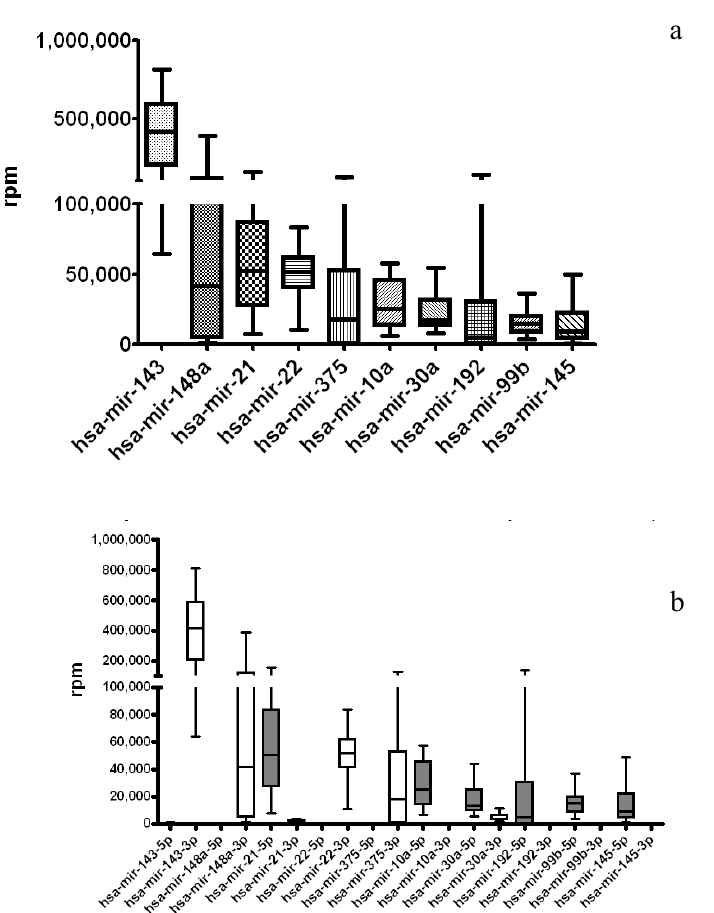
Figure 3. Distribution of the top ten expressed miRNAs from the TCGA (the Cancer Genome Atlas) normal gastric tissue dataset. miRNA expression data of 38 normal samples in TCGA stomach adenocarcinoma (STAD) libraries were re-analyzed using the new arm feature list. ( a ) The rpm (reads per million) values of each miRNAs were tabulated by combining the 5p-arm and 3p-arm together to represent the miRNA loci expression; ( b ) 5p-arm and 3p-arm expression levels were tabulated separately and displayed. miR-143 is the most expressed miRNA in the TCGA clinical normal